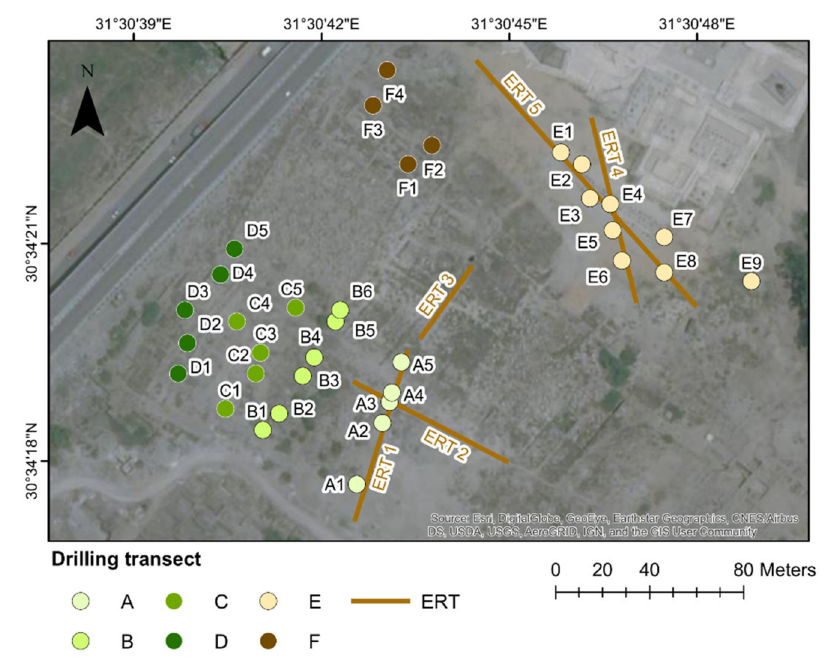
Figure 2. Overview of drilling locations and the position of 2D Electrical Resistivity Tomography (ERT) profiles (Database: © Esri